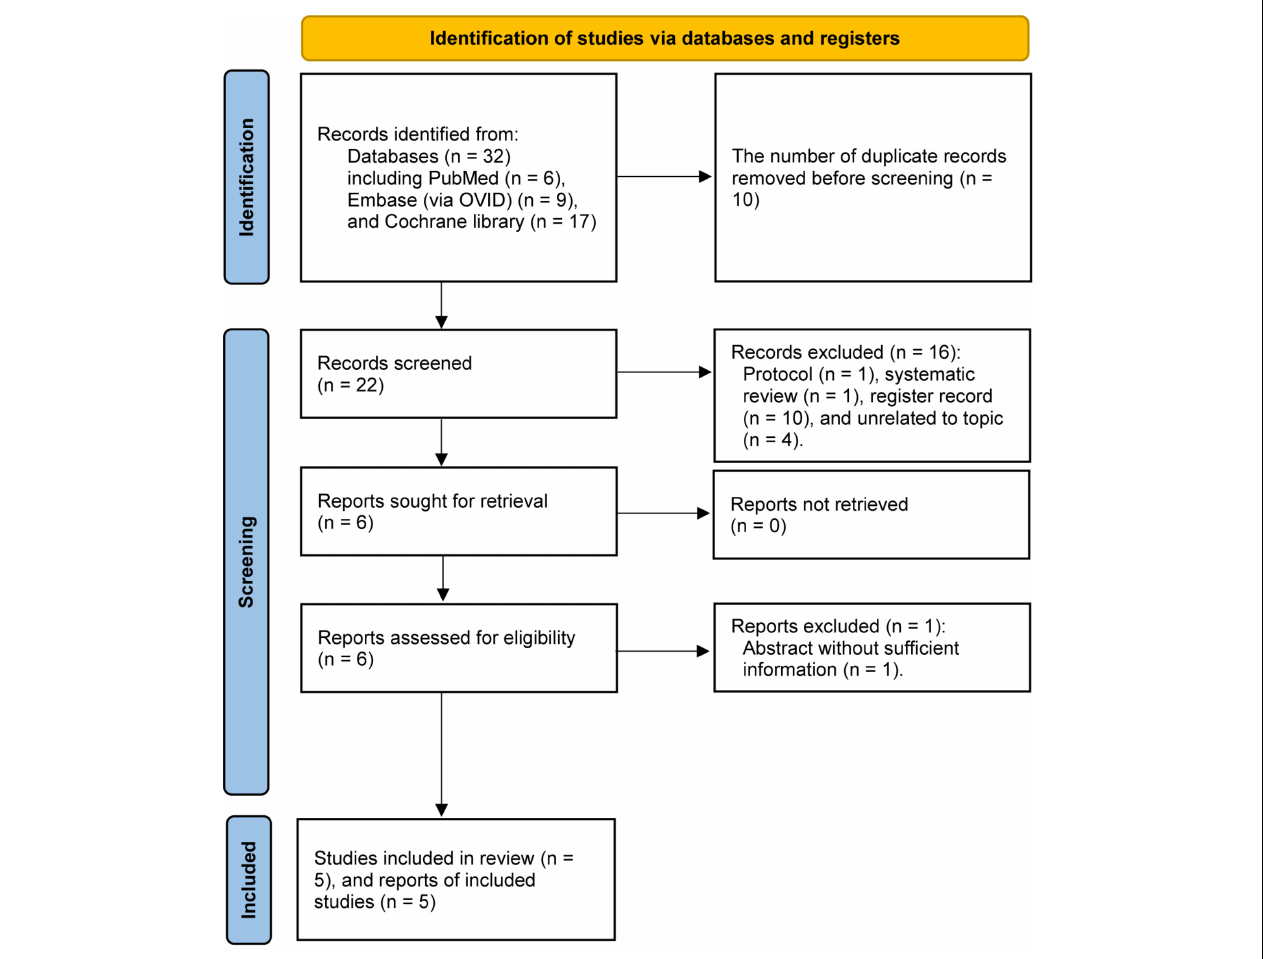
FIGURE 1 | The Preferred Reporting Items for Systematic Review and Meta-analyses (PRISMA) flow chart of capturing and selecting